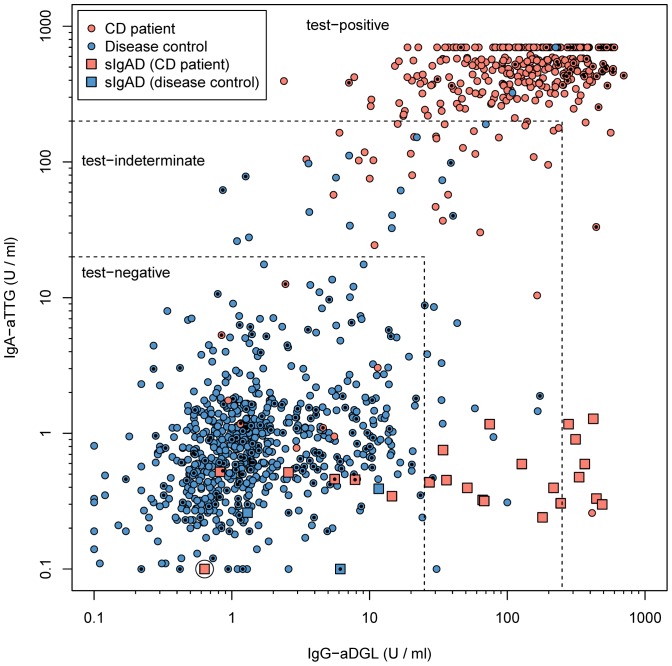
IgA-aTTG and IgG-aDGL in 376 CD patients (red) and 695 controls (blue).Patients with sIgAD are denoted by a larger square and a black dot in the centre indicates that the child was below two years of age. The large circle indicates that this is the CVID patient. Dashed lines show the three regions for the two-test procedure. Values smaller than 0.1 are depicted in the plot as though they were 0.1 and those greater than 700 as though they were 700. Note, that all patients with sIgAD had a concentration of IgA-aTTG below 2 U/ml.